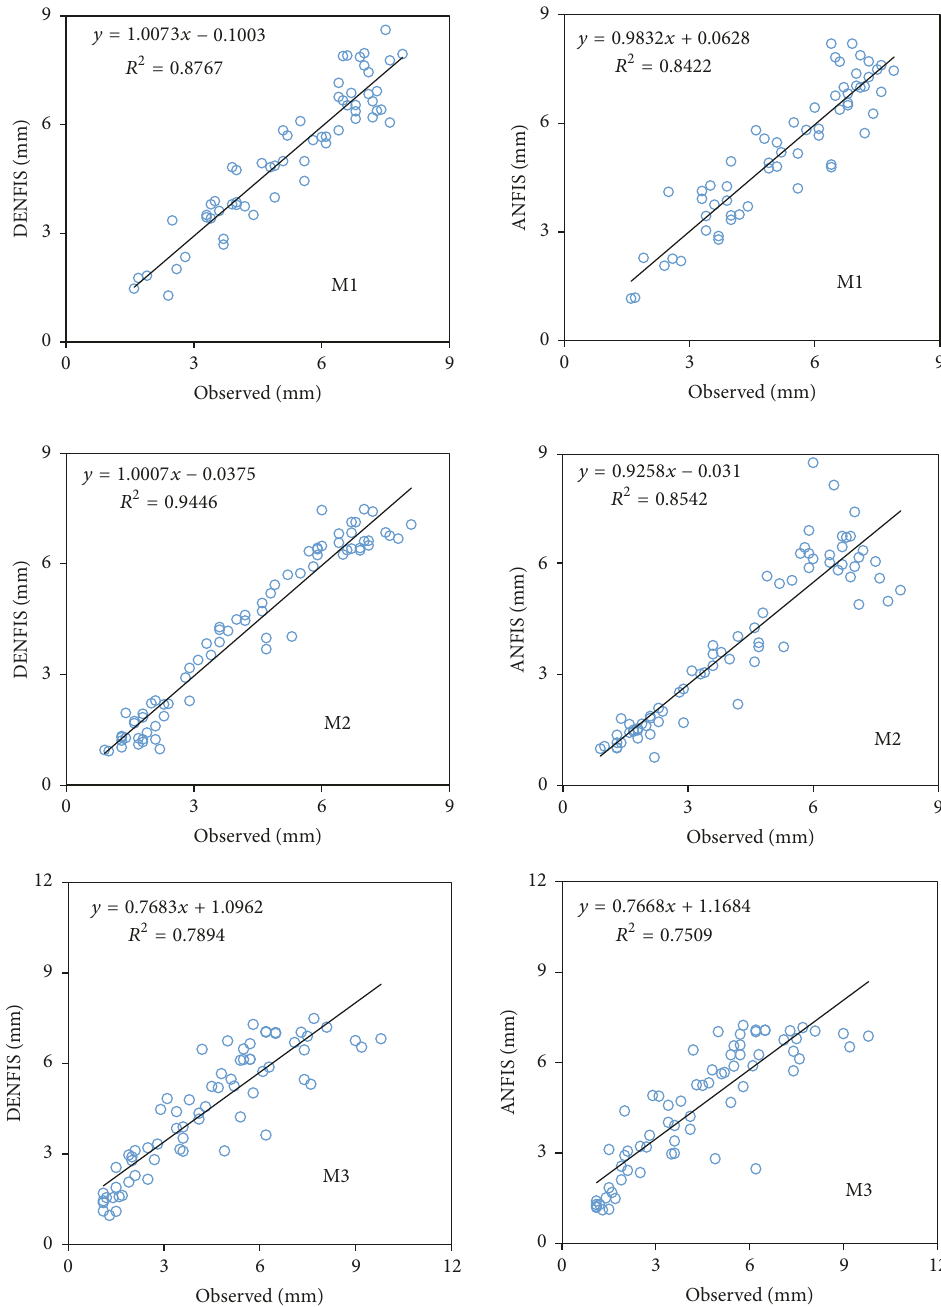
Figure 3: The observed and estimated pan evaporation using DENFIS and ANFIS methods for the M1, M2, and M3 data sets—Antakya.